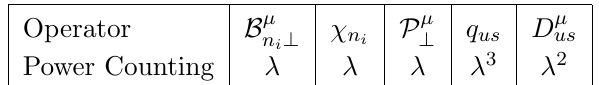
Table 1 . Power counting for building block operators in SCET I